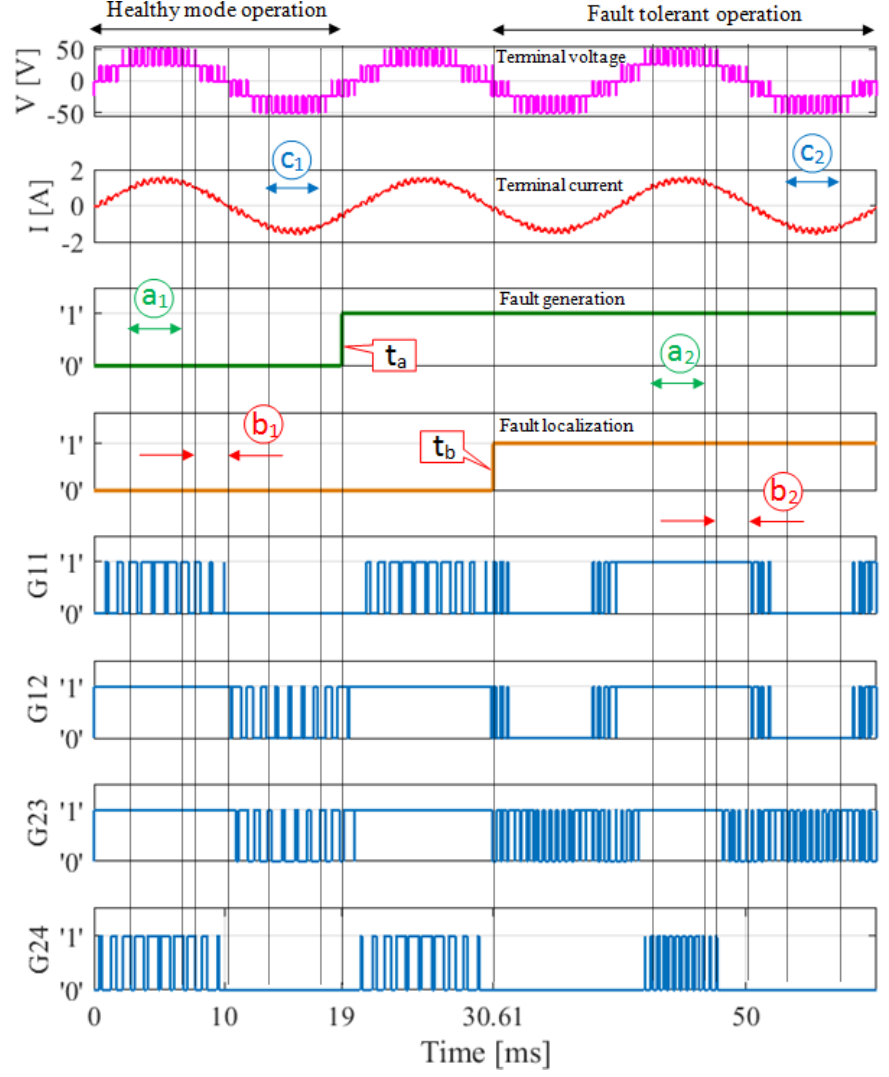
Figure 5. Simulation results for fault-tolerant operation of the inverter in the case of a short-circuit fault event in S12.